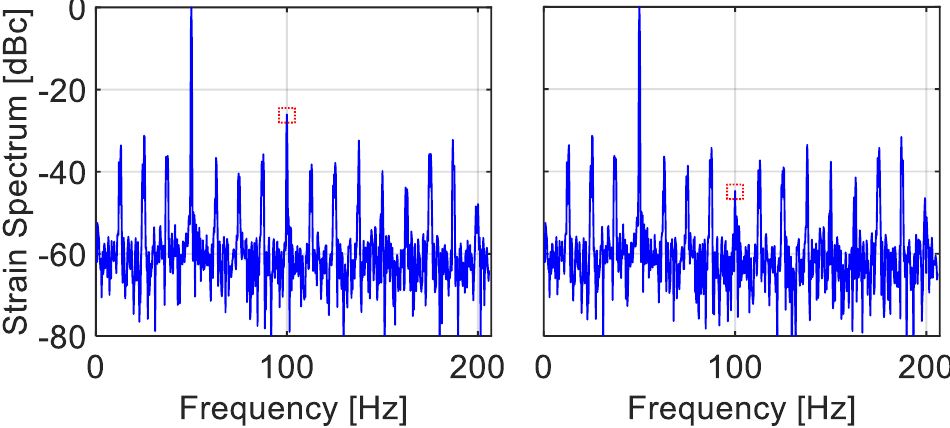
Figure 11. ( Left ) Hamming-weighed FFT spectrum of raw BFS vs. time 50 Hz vibration data, obtained from the experimental setup of Figure 8. Here, the scan rate is 412 Hz, the scan range is 112 MHz and the vibration amplitude 17 MHz, resulting f signal / f scan = 0.12 and ν signal − amp / ν span scan = 0.15, respectively. Note the − 26 dB second harmonic peak at 100 Hz (dotted square). While lower than the − 16.3 dB one of Figure 10, it is still higher than the spectrometer-based measurement of below − 37 dB (The observed peaks are again folded high harmonics). ( Right ) Using the measured instants of acquisition, { τ n } N − 1 , and the procedure of spline interpolation of Section 3, the second harmonic is down to − 44.7 dB (dotted square) but there is now a dominant harmonic at − 31 dB. Record duration is 3.6 s.